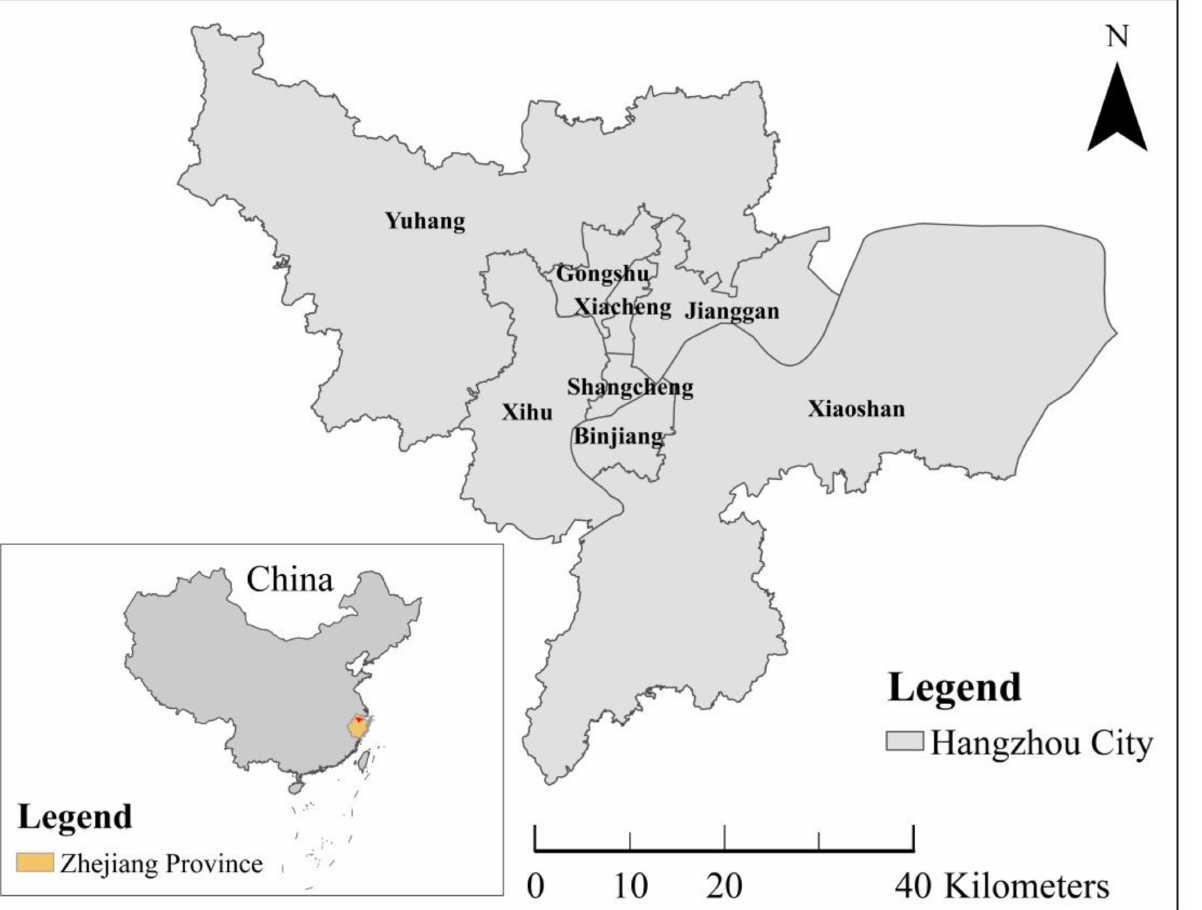
Figure 1. Hangzhou city and its eight administrative